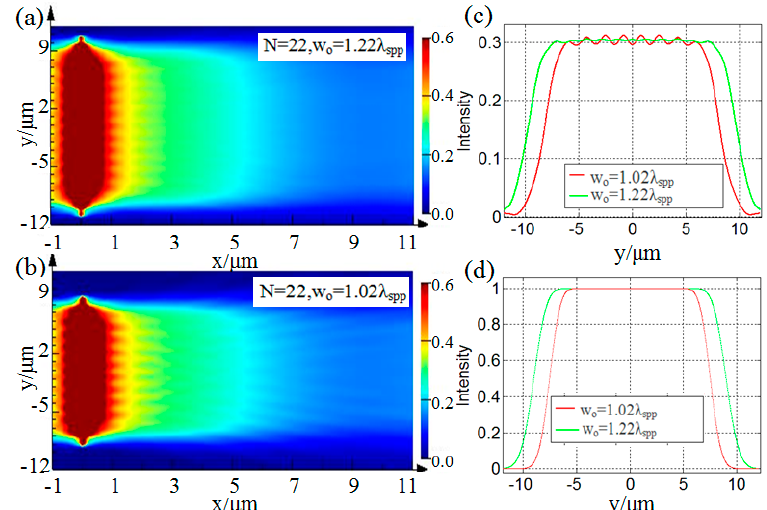
Figure 4. The intensity distributions of the generated flat top SPP beams under N = 22, ( a ) w o = 1.22 λ spp , ( b ) w o = 1.02 λ spp . ( c ) A comparative diagram of the transverse profile intensity distributions extracted at x = 3 μ m from ( a ) and ( b ). ( d ) A comparative diagram of the transverse profile intensity distributions calculated by Equation (1).